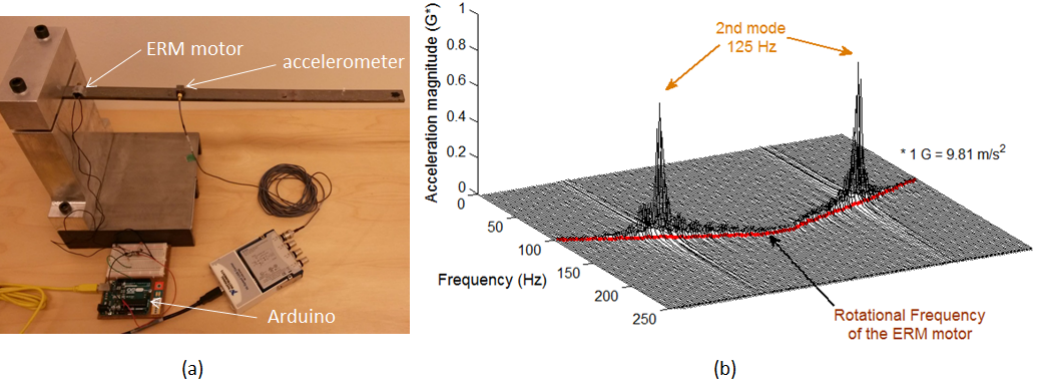
Figure 19. ( a ) Experimental setup where an eccentric rotating mass (ERM) motor is used to excite beam vibrations; ( b ) waterfall plot of the beam acceleration vibration response for a run-up and run-down speed variation of the ERM